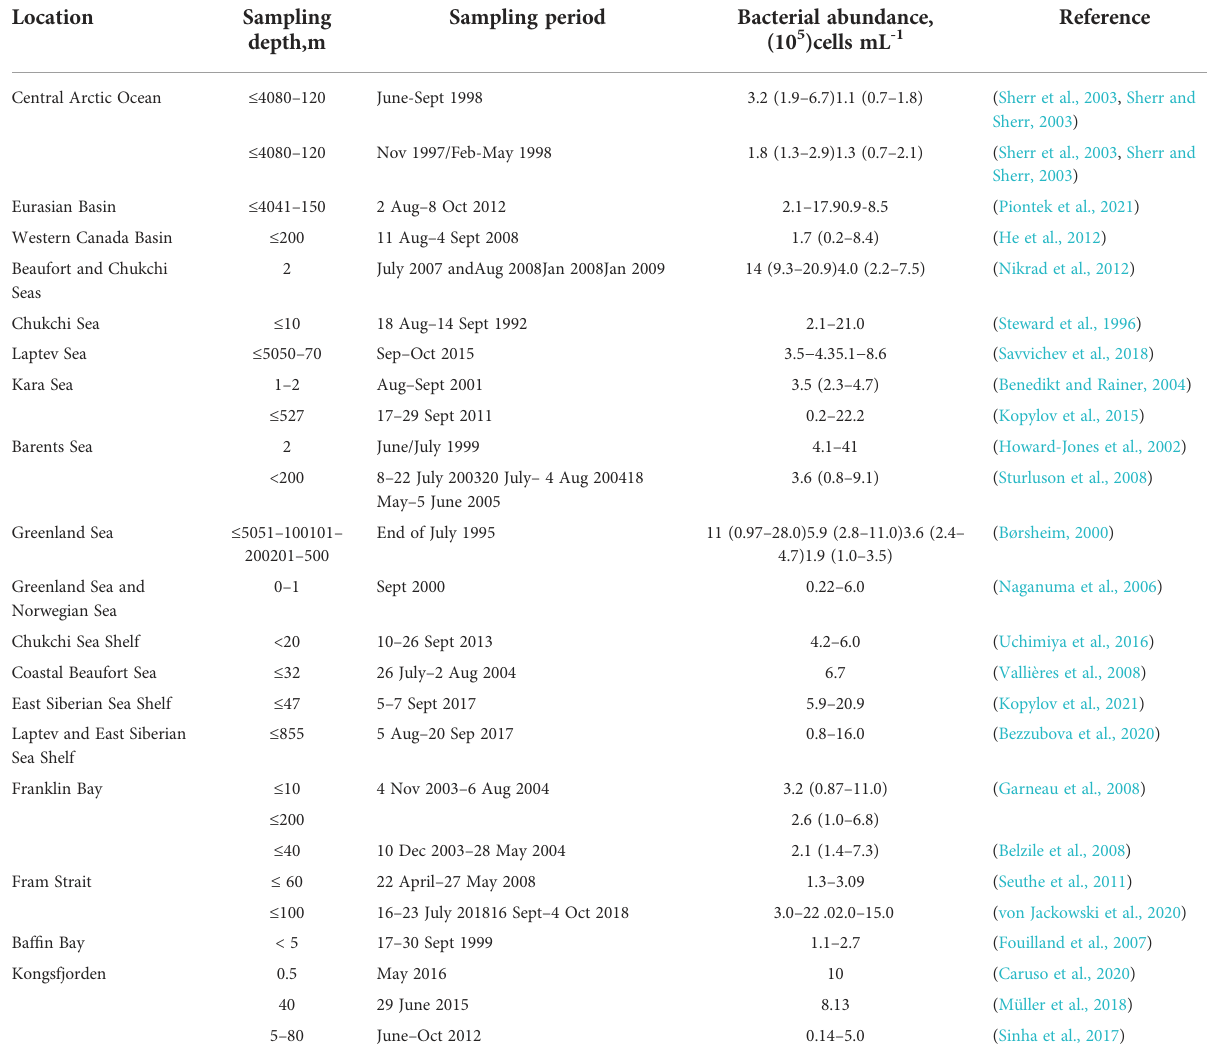
TABLE 2 Summary of bacterial abundance in sea waters of the Arctic